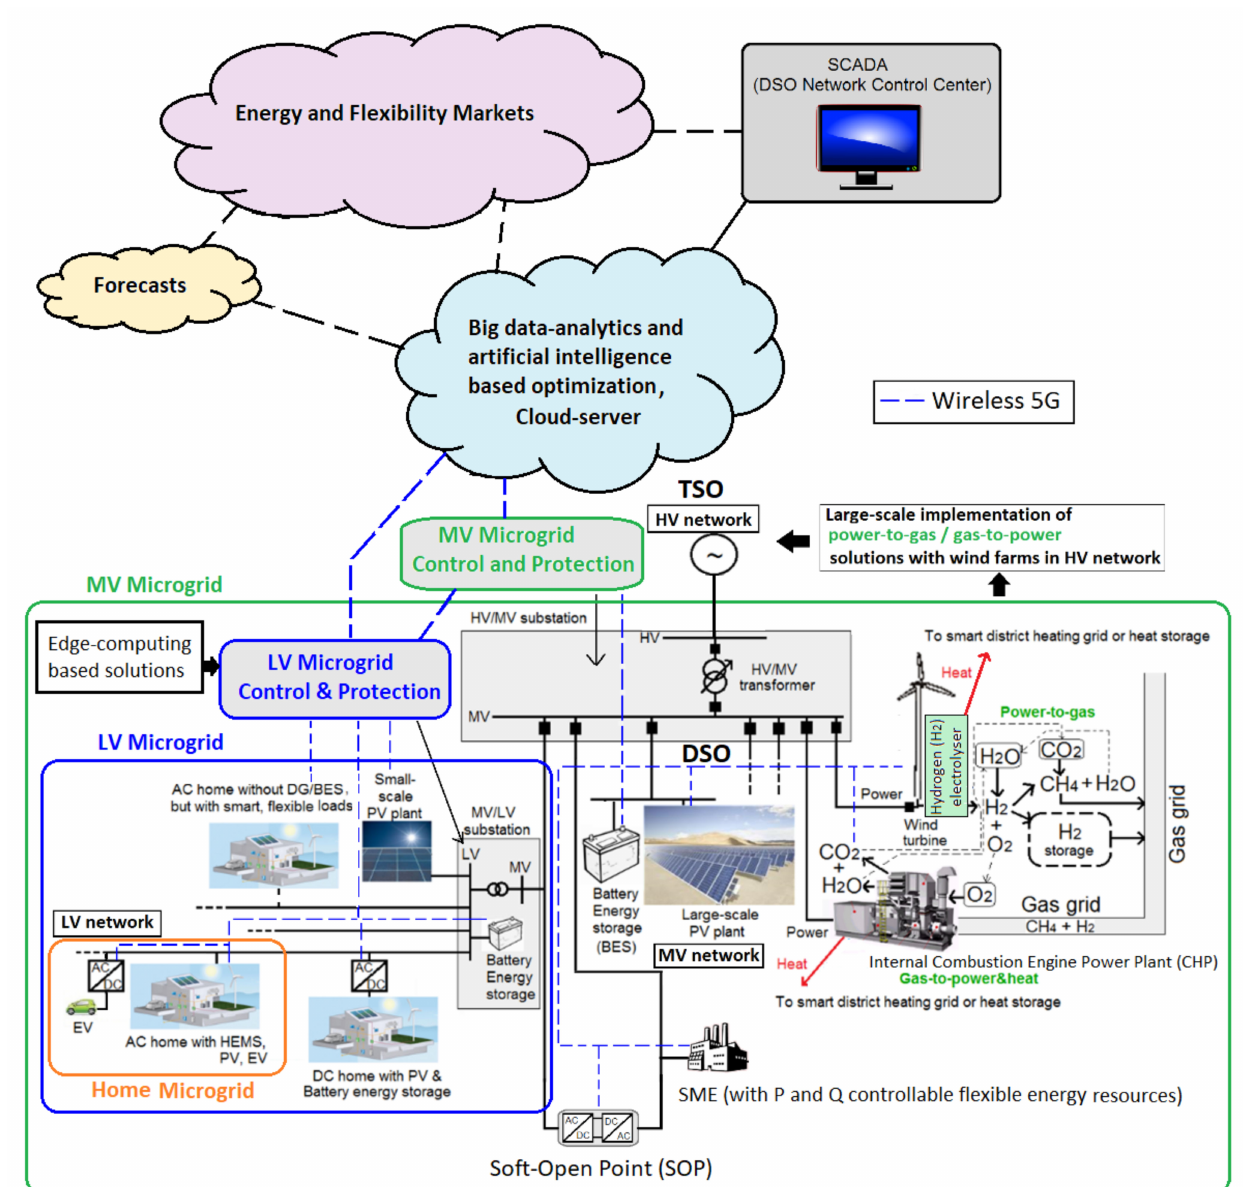
Figure 2. Future flexible and digitalized electricity distribution system. The evolution stages are dependent on different issues (1–14) and dependencies between them as well as on the level of the existence/deployment of these matters (Tables 1 and 2 and Figure 3). In this paper, the focus is on the evolution and devel- opment of adaptive control and management methods. Therefore, in Table 2, the potential evolution of (10) adaptive control and management methods, (11) accurate monitoring of distribution networks, and (12) advanced ICT-based protection and control solutions during stages 1–3 (see Table 1) is described as an example with more